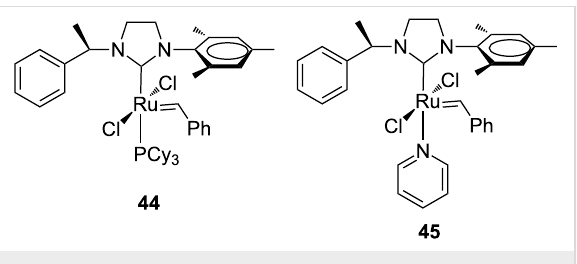
Figure 12: Grubbs-type complex 44 and its monopyridine derivative 45 containing a chiral uNHC.